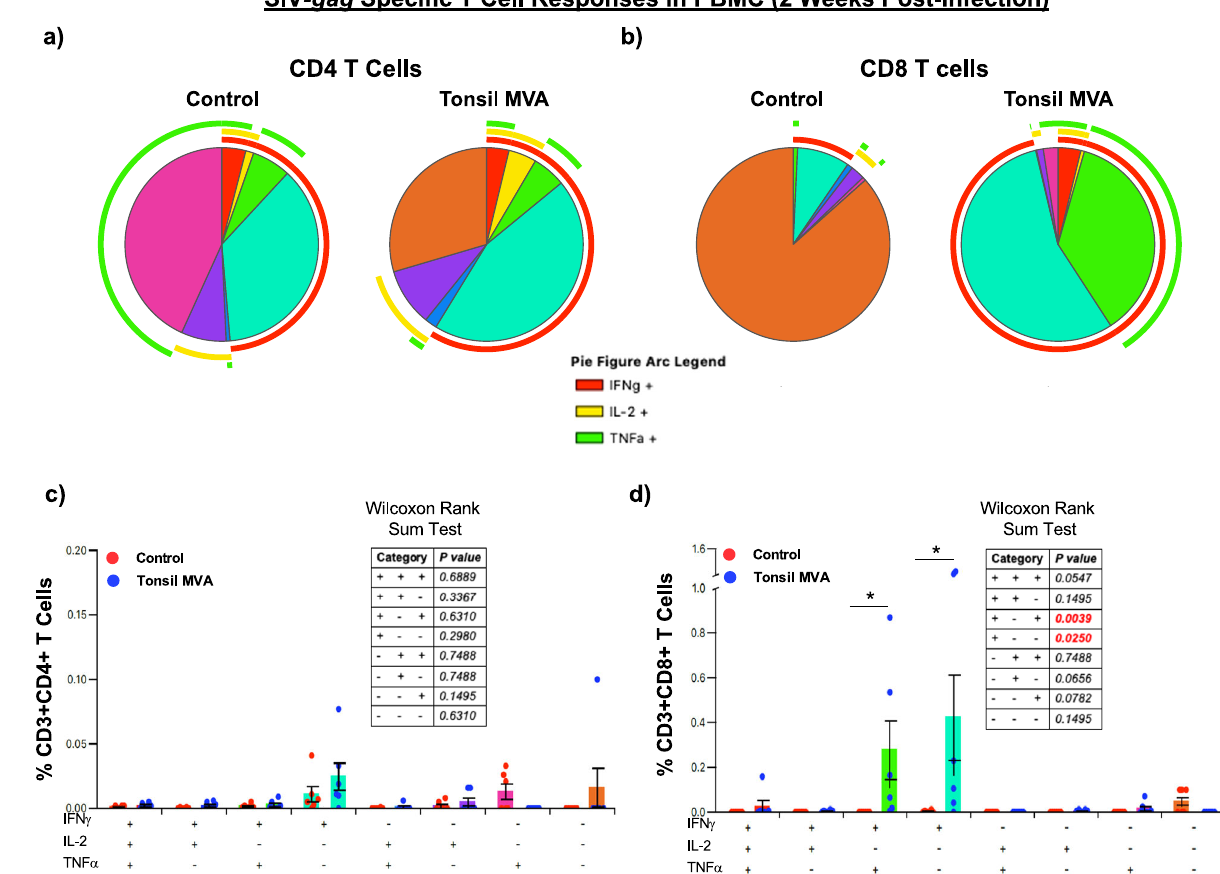
Fig. 8 | Tonsil vaccination induced signi fi cant levels ofSIVmac239-gag speci fi c poly-functionalCD8Tcellresponsesinperipheralblood. Qualitativeanalysisof SIVmac239-gagspeci fi cIFN γ ,IL-2,andTNF α expressioninperipheralblood( a )CD4 and( b )CD8Tcellsofcontrol( n =6)andtonsilvaccinated( n =6)animalsat2weeks post infection. Frequency of ( c ) CD3 + CD4 + T cells and ( d ) CD3 + CD8 + T cells in